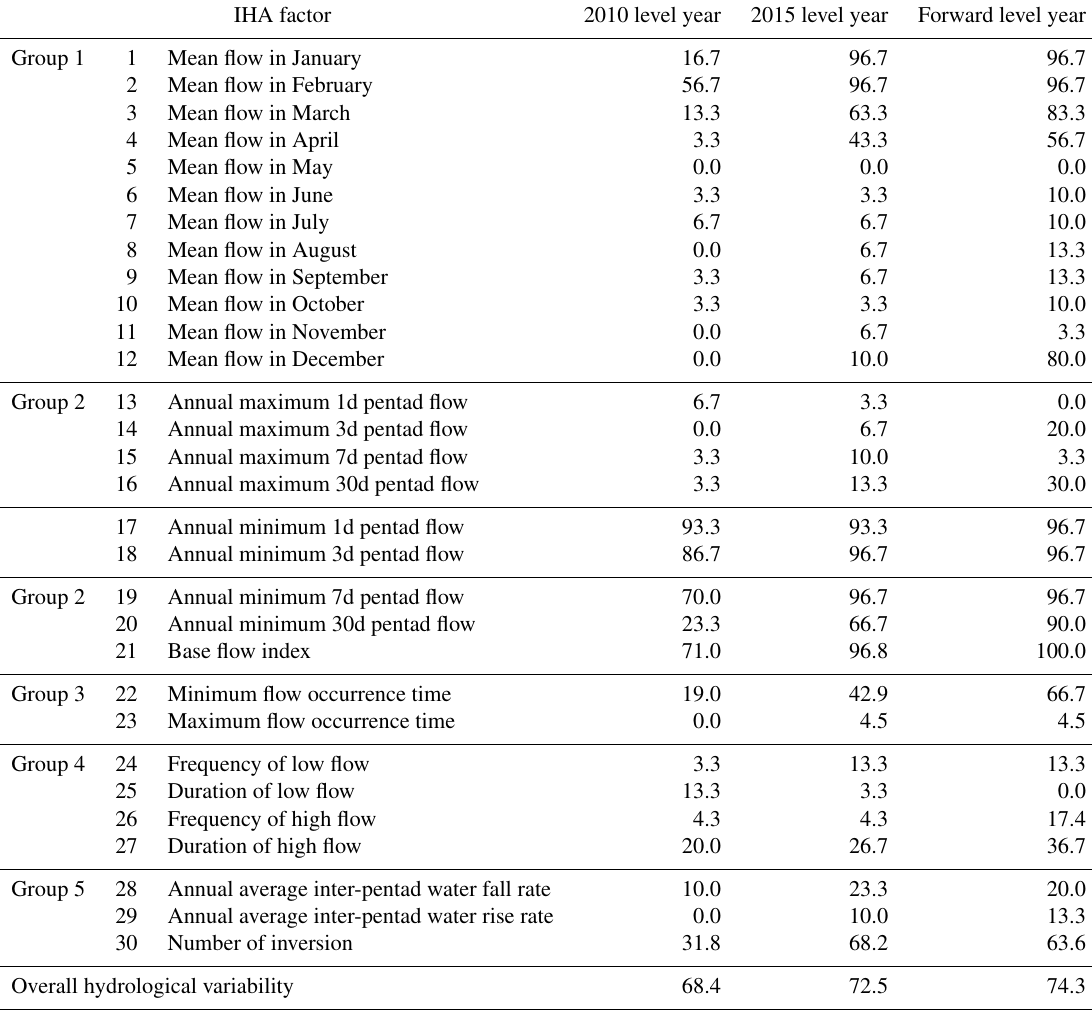
Table 4. RVA calculation results of hydrological variability of Yichang hydrological station in different level years (%). IHA factor